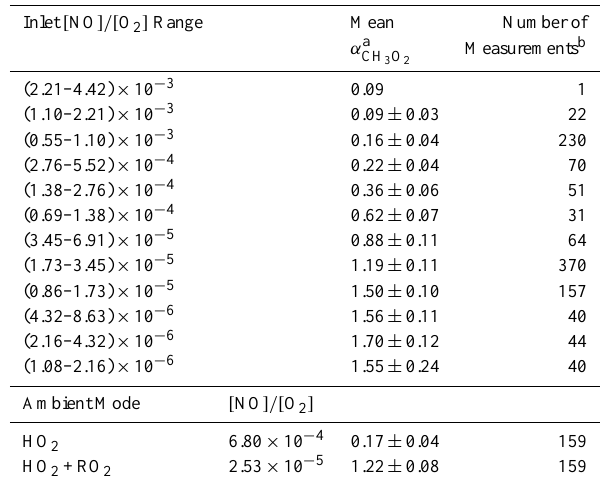
Table 2. Summary of the mean α CH periments according to inlet [ NO ] / [ O 2 ]